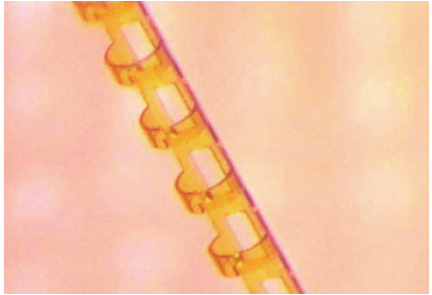
Figure 9: Stegmann Canal Expander design.